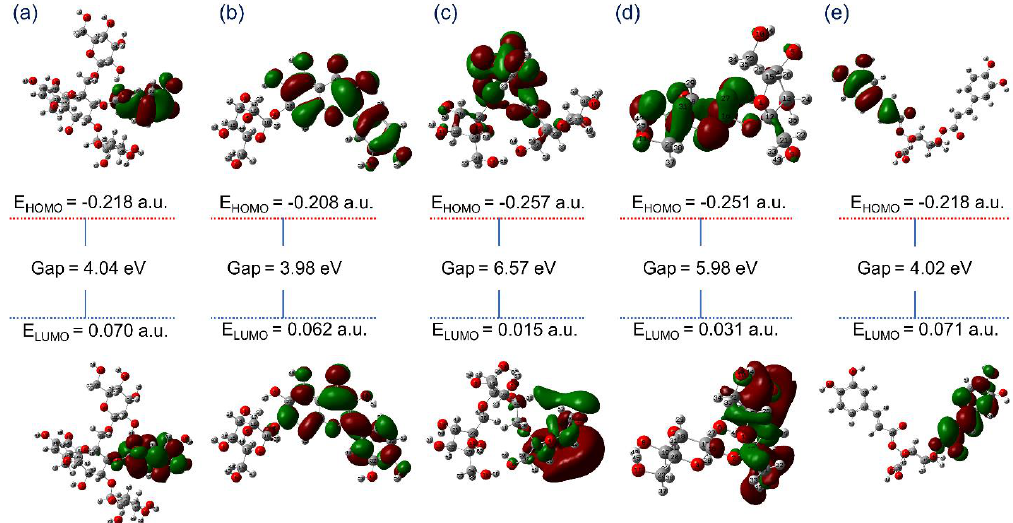
Figure 3. Molecular orbitals, i.e., highly occupied molecular orbital (HOMO) and lower unoccupied molecular orbitals (LUMO) of the optimized geometries of selected natural compounds, viz. ( a ) Echinacoside, ( b ) Quercetagetin 7-glucoside, ( c ) Levan N, ( d ) Inulin from chicory, and ( e ) 1,3-Dicaffeoylquinic acid, calculated using theoretical model B3LYP/6-31G** method.